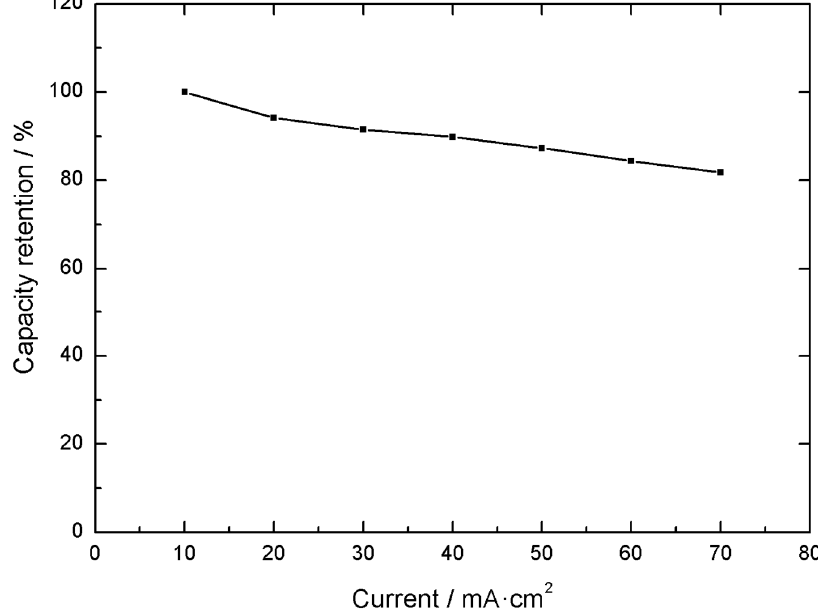
Figure 5. Capacity retention obtained for nickel-cobalt hydroxide calculated at different applied current densities calculated from the third discharge curve in the − 0.3 V to 0.5 V vs. SCE voltage interval.